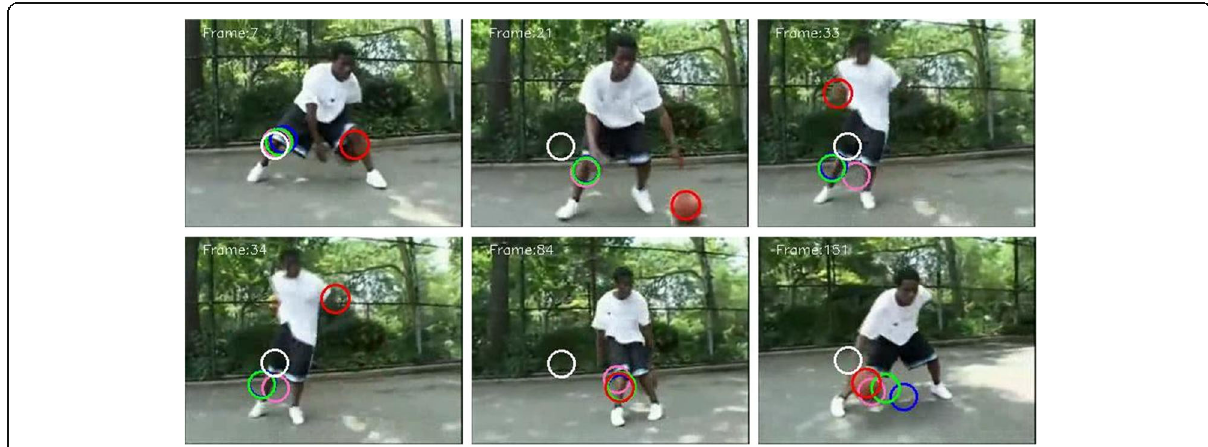
Fig. 15 The tracking results for the video “ basketball_2 ” using CAM-Shift (white), PF (blue), VAPF (green), M-PF (pink), and the proposed tracker (red). Particle number N = 250